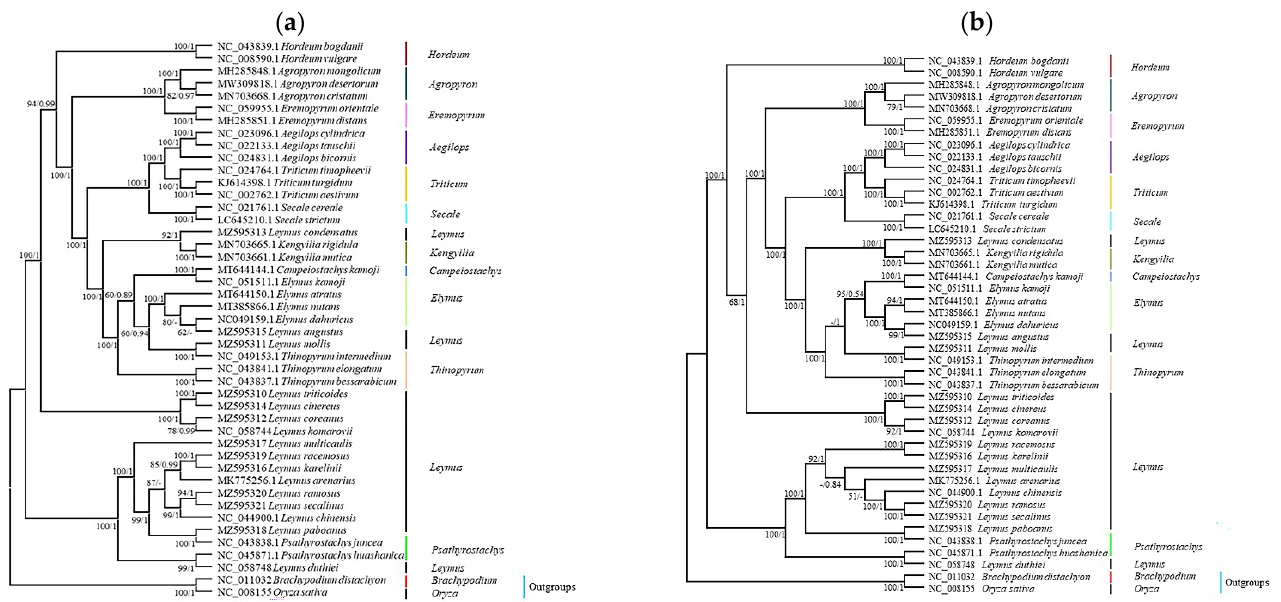
Figure 8. Phylogenetic tree of the Leymus species. Brachypodium distachyon and Oryza sativa Indica were selected as the outgroups. The tree was constructed by maximum likelihood and Bayesian inference with bootstrap values or posterior probabilities being indicated above the branches. The bootstrap values or posterior probabilities no more than 50% or 0.5 were shown in “-”. ( a ) Based on complete cp genome data; ( b ) based on 74 shared protein-coding genes.